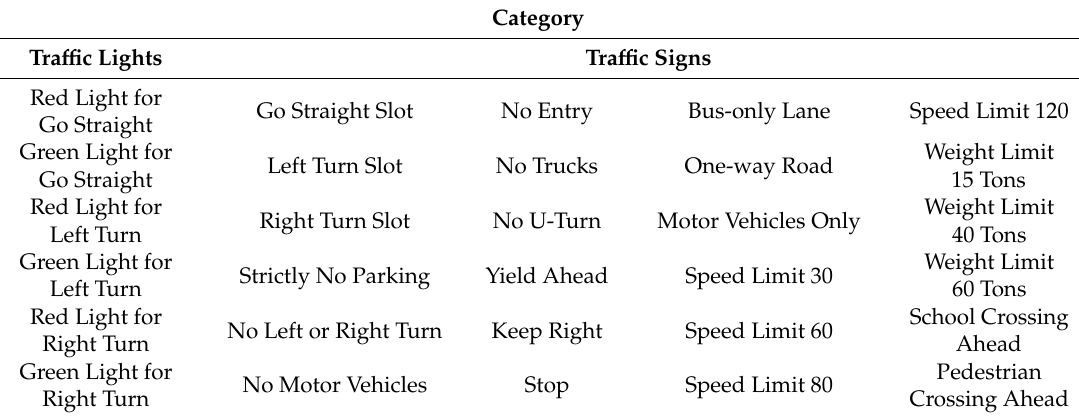
Table 4. Categories of data set